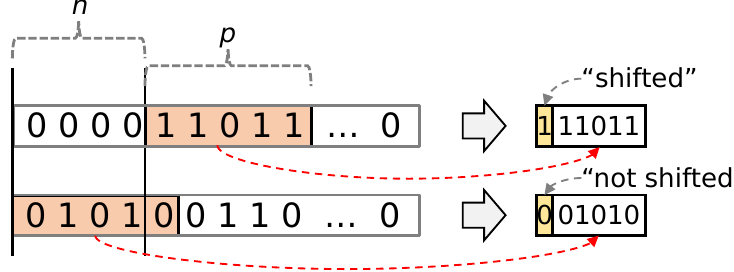
Figure 1. ZFPe encoding using n = 4 and p =